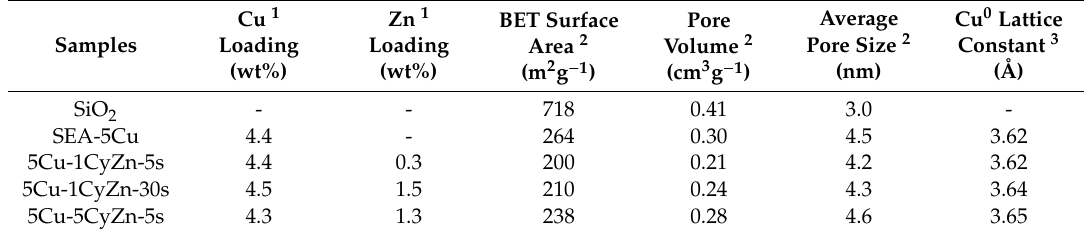
Table 1. Bulk properties of SiO 2 , SEA-5Cu, and ZnO over-coated Cu/SiO 2 catalysts. Samples